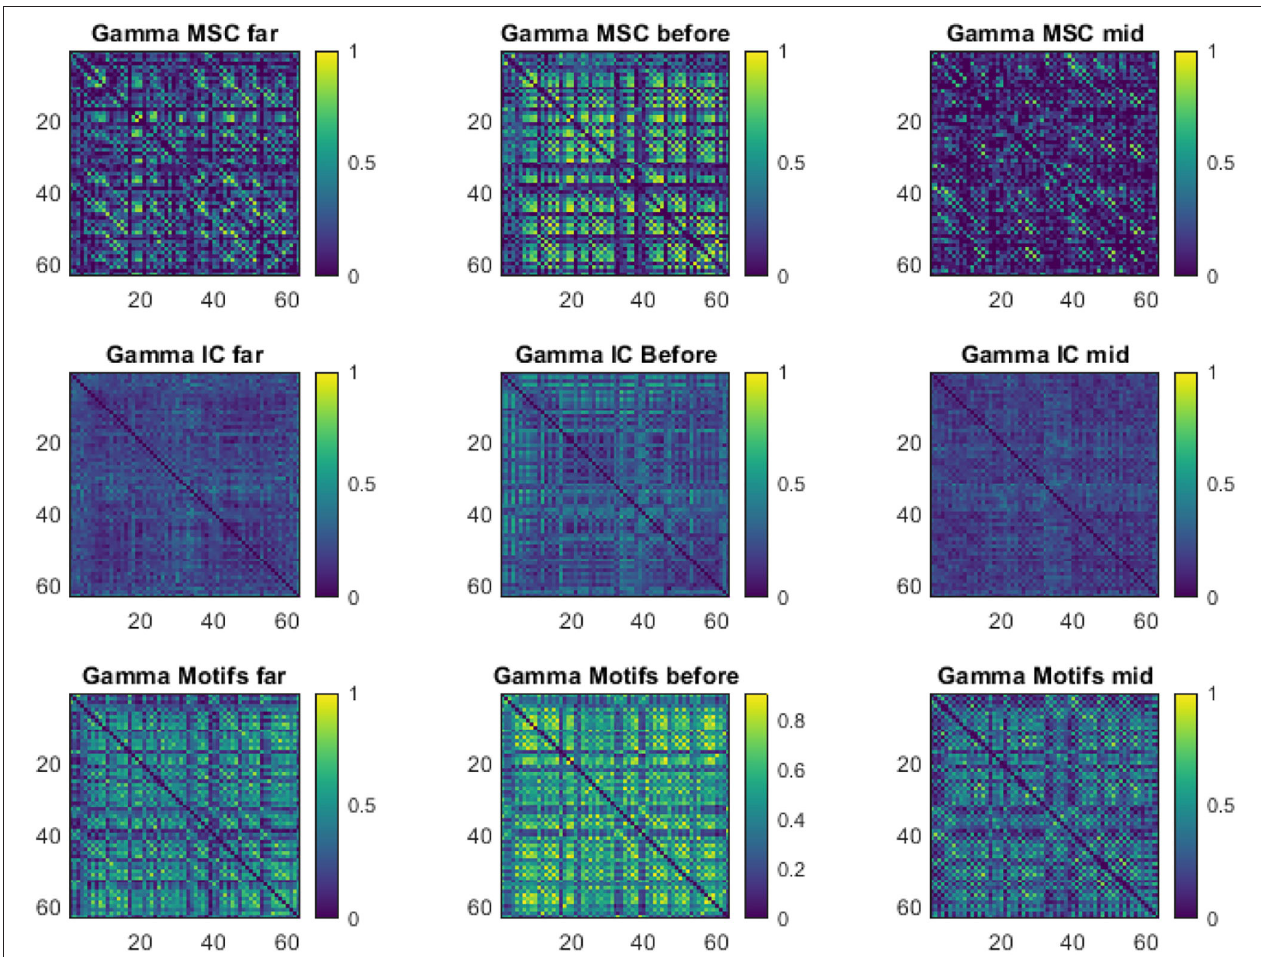
FIGURE 6 | Gamma band FC matrices of a patient for three representative epochs of EEG segment types far, before, and mid (columns). Each epoch is represented by three matrices, one for each FC technique. Top row: MSC, middle row: IC, bottom row: motifs.